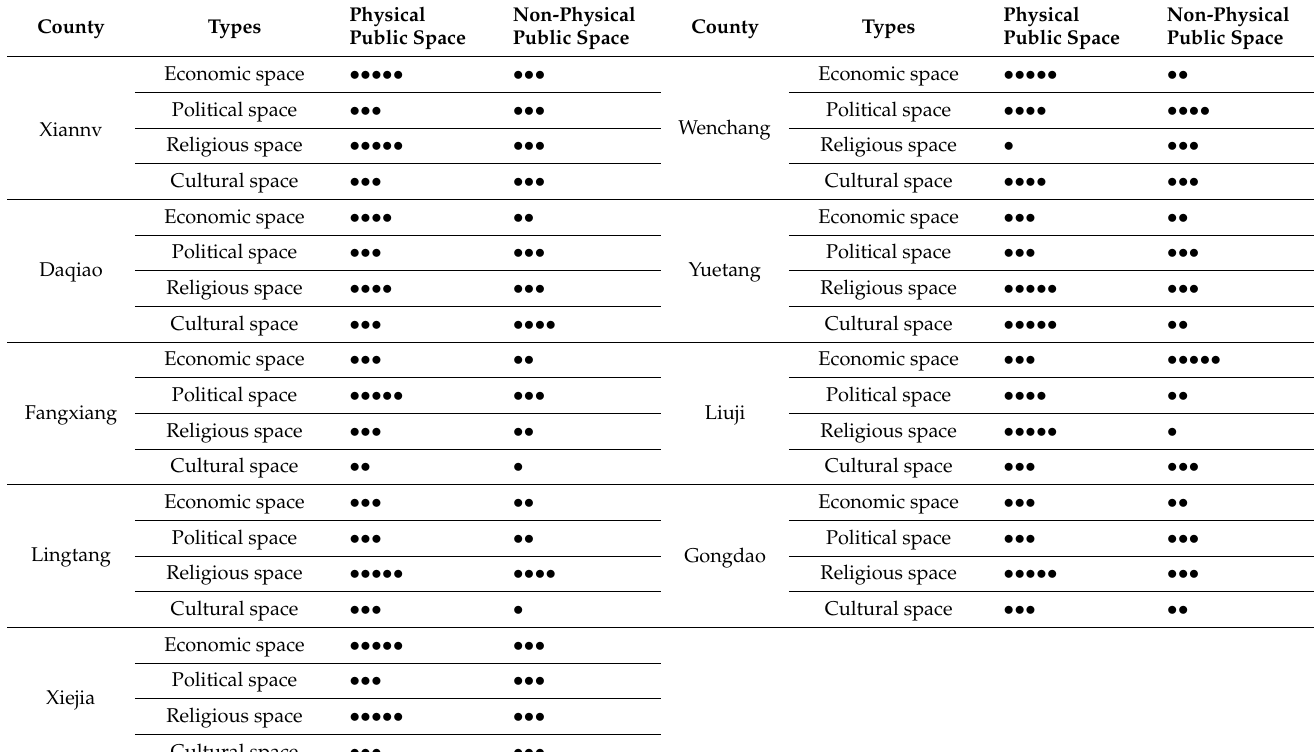
Table 3. The distribution of public space in nine counties.